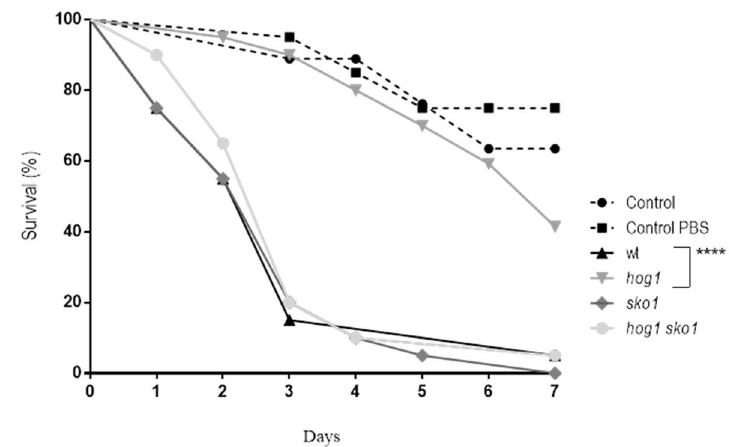
Figure 3. Virulence of C. albicans in a G. mellonella systemic infection model. 10 6 C. albicans cells were injected at the last left pro-leg of G. mellonella larvae and survival of the insect was followed in time. Control refers to G. mellonella larvae that was not inoculated and control PBS indicates larvae that was inoculated with PBS as stress control. Kaplan-Meier survival curves are shown and the Log-rank (Mantel-Cox) test displayed significant differences between the hog1 mutant and the parental wild type strain. **** p <0.0001.